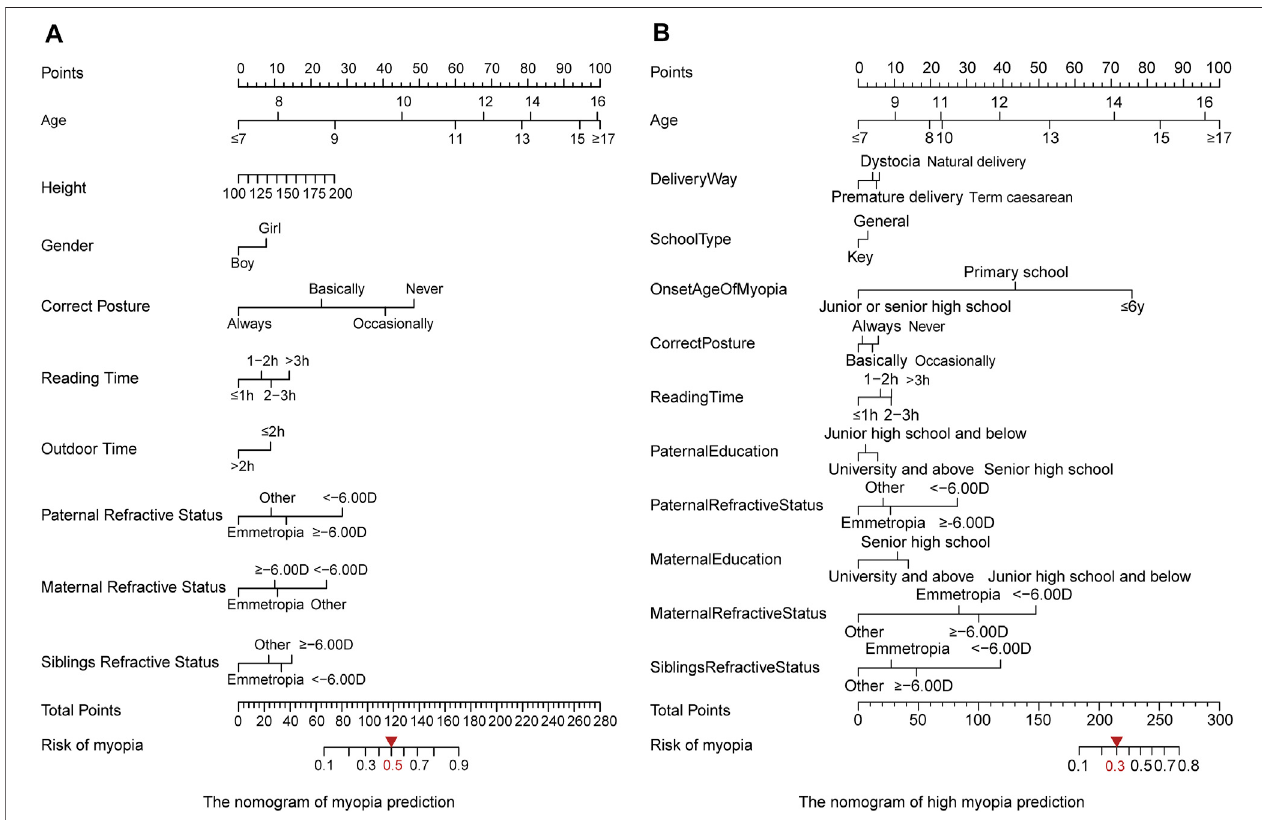
FIGURE4| NomogramoftheMAPmodeltoevaluatetheprevalenceofmyopia. (A) Myopiamodeling.Byoptimizingtheindicatorsusingthetrainingcohort,weset the threshold of 0.5 for assigning the high risk. (B) High myopia modeling. The threshold of 0.3 was selected for assigning the high risk.